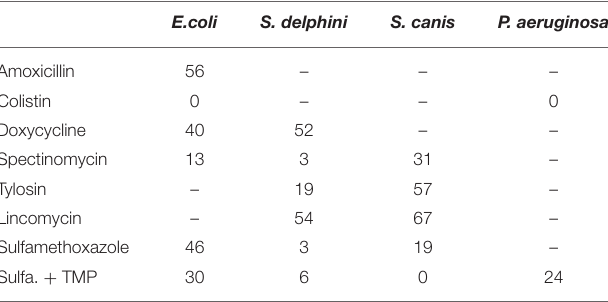
TABLE 6 | Percentages of isolates in non-wildtype population.